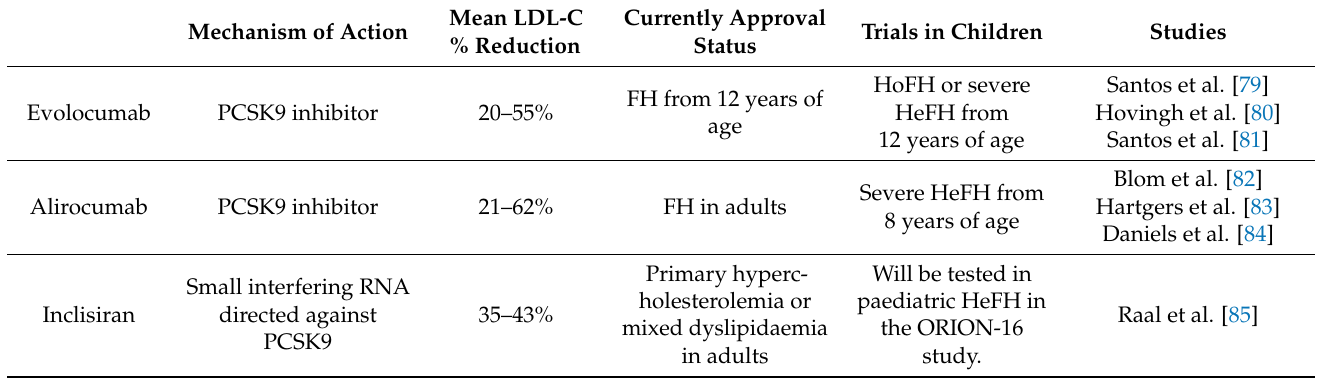
Table 2. Novel lipid-lowering